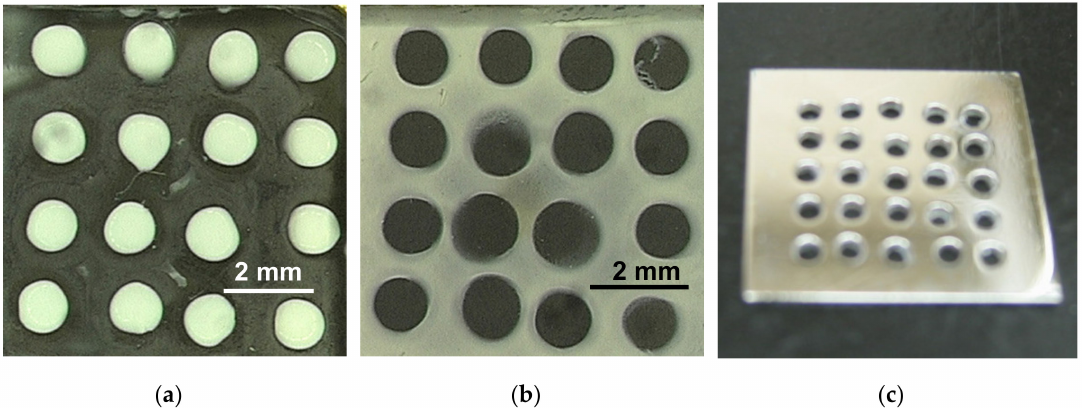
Figure 4. ( a ) Patterned polystyrene nanoparticles (sizes of 1.0 µ m, diamagnetic) and ( b ) patterned polystyrene nanoparticles including Eu (sizes of 260 nm, paramagnetic) formed on a glass plate placed on ( c ) permalloy substrate with holes. The direction of the applied magnetic field of 8 T was normal to the